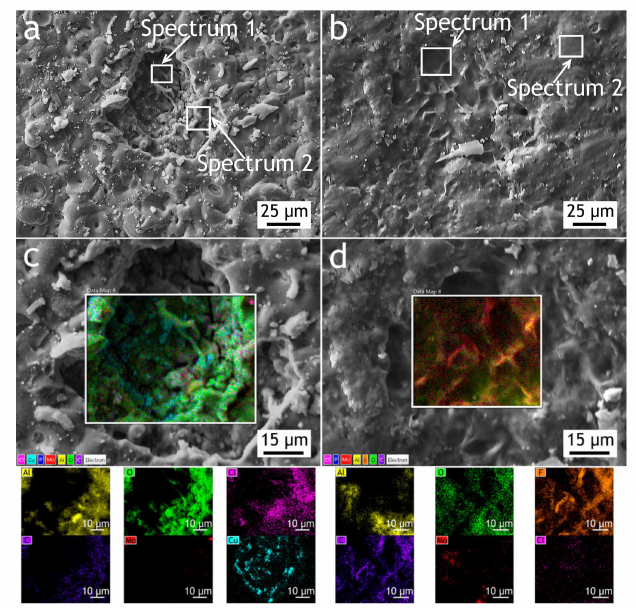
Figure 7. SEM images and EDX maps for the PEO-coating—( a , c ) and CC—( b , d ) after potentiodynamic polarization test performed in 3% NaCl. Table 4. Surface elemental composition near the pits formed after the potentiodynamic polarization (Figure 7). PEO CC Spectrum 1 Spectrum 2 Spectrum 1 Spectrum